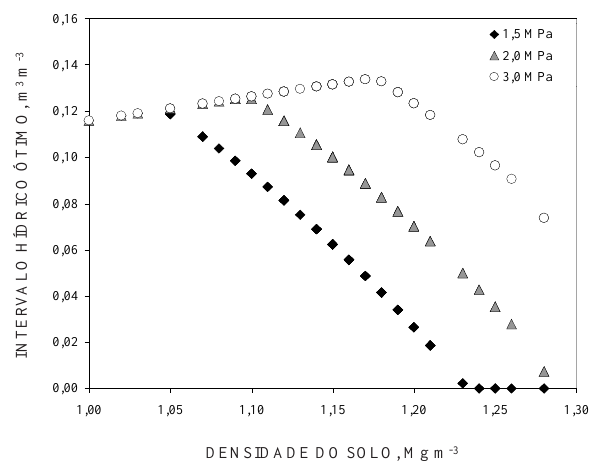
Figura 3. Variação no Intervalo Hídrico Ótimo em função da densidade do solo em diferentes níveis críticos de resistência à